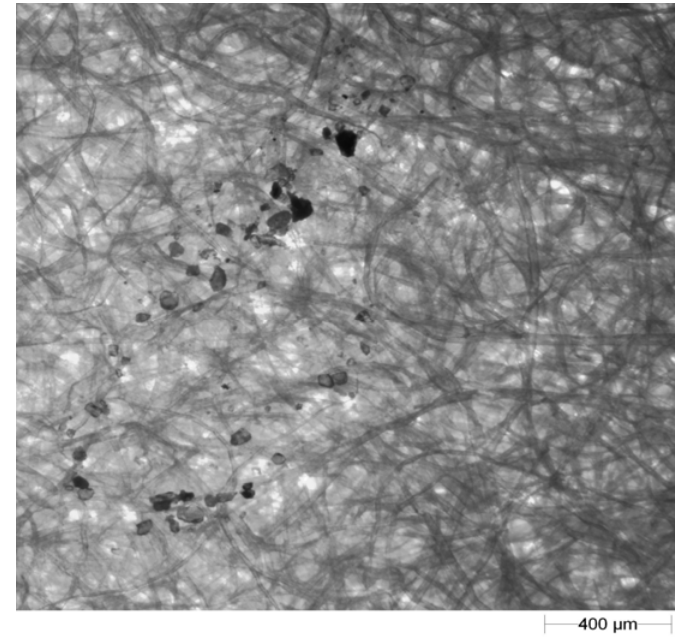
Figure 2. An example image of splashed particles on blotting paper.